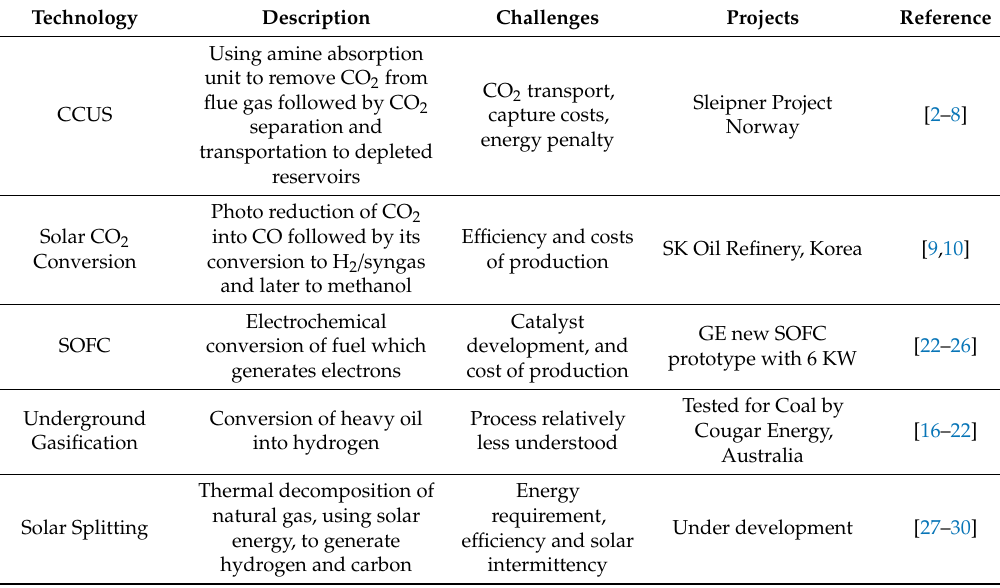
Table 1. Summary of emerging clean hydrocarbon